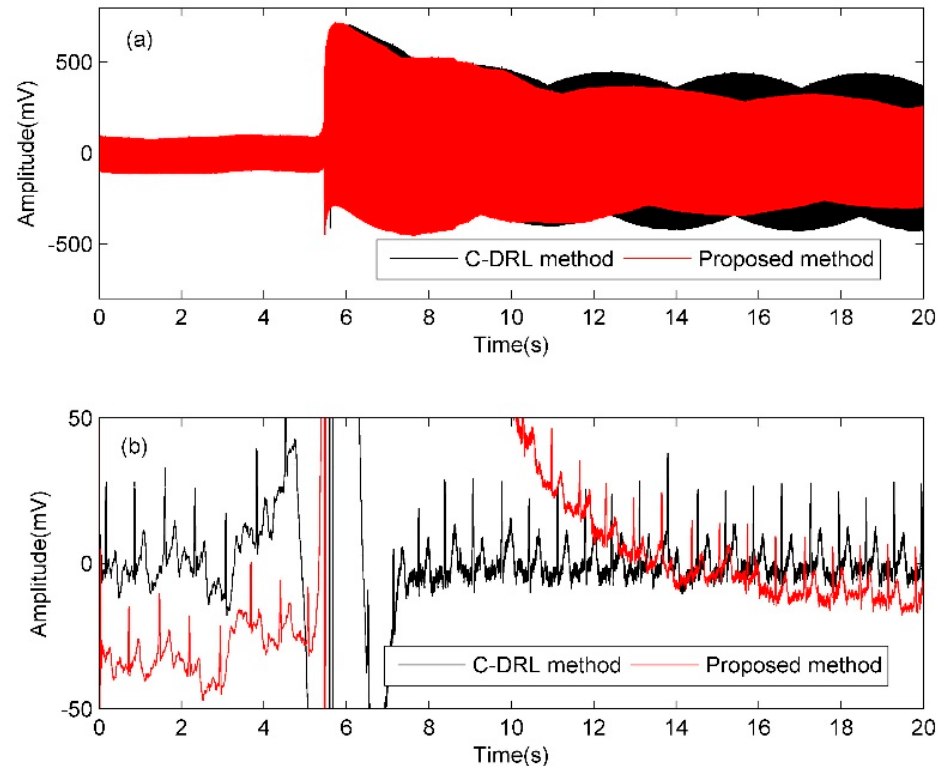
Figure 15. Simultaneous measurement results of human chest ECG acquisition for the process of the upper being still, rotating to one side substantially and being still again, ( a ) time-domain waveform of original signal, ( b ) ECG signal processed by software notch.